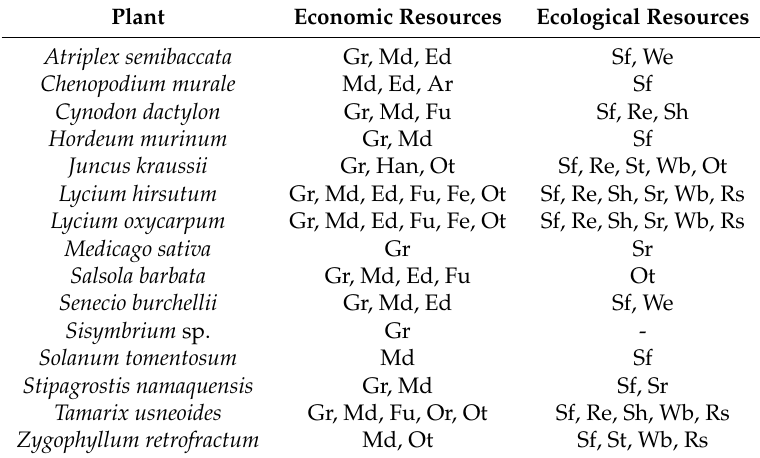
Table 4. Summary of the economic and ecological resources provided by some of the trees, shrubs, and herbs sampled along the Swart, Olifants, and Leeu riparian zones [57]. Economic sources include: Grazing (Gr), Medicinal (Md), Aromatic source (Ar), Edible food (Ed), Fuelwood (Fu), Fencing + Windbreak (Fe), Ornamental (Or), Making handicrafts (Han), and other uses, such as shelter, rope making, and thatching (Ot). Ecological resources include Sand stabilization (Sf), Refuge (Re), Shading (Sh), Soil fertility (Sr), Salt tolerance (St), Wind break (Wb), Weed (We), Waterpoint stabilisation (Rs), and other resources such as bioremediation and pollen supply (Ot).